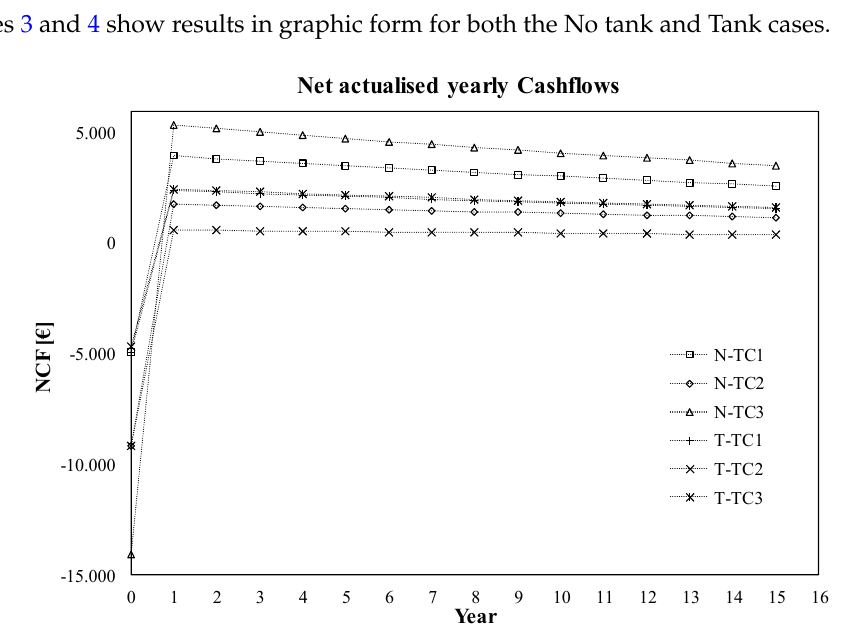
Figure 3. Net actualized cash flows generated in all scenarios.